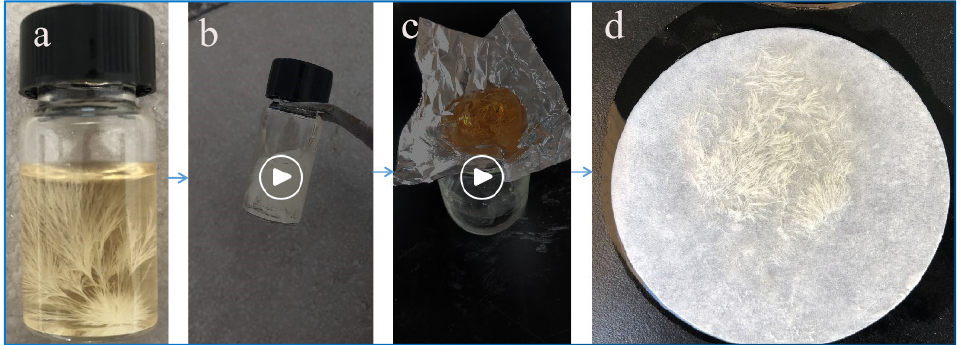
Figure 7. EVA crystals were recovered from CMCS/EVA co-mixture gels. ( a ) EVA growth in CMCS gel, ( b ) 0.1M HCl hydrolyze CMCS gels, ( c ) EVA crystals float in CMCS solution and ( d ) EVA crystals recovered from membrane filtration.